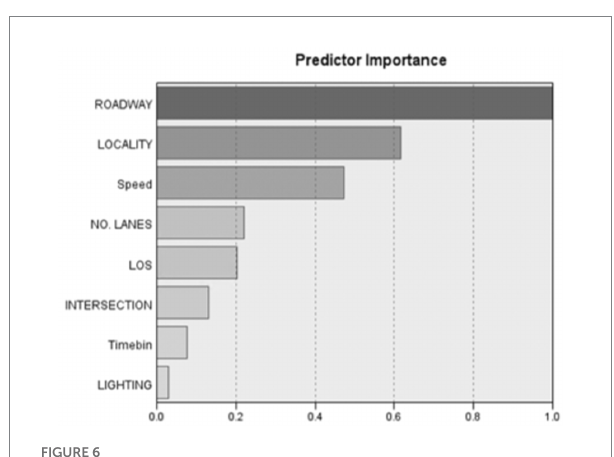
FIGURE 6 Predictor importance for two-step